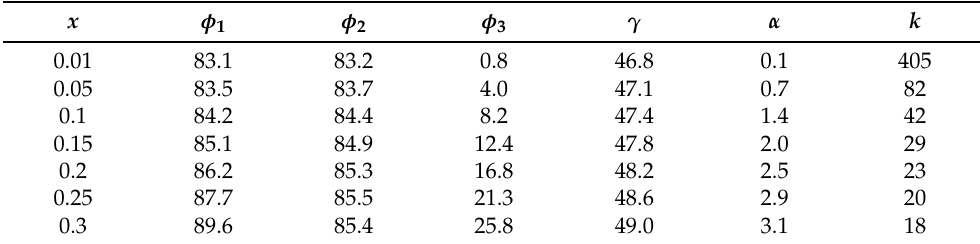
Table 4. Optimal angles and curvature for a curved woven